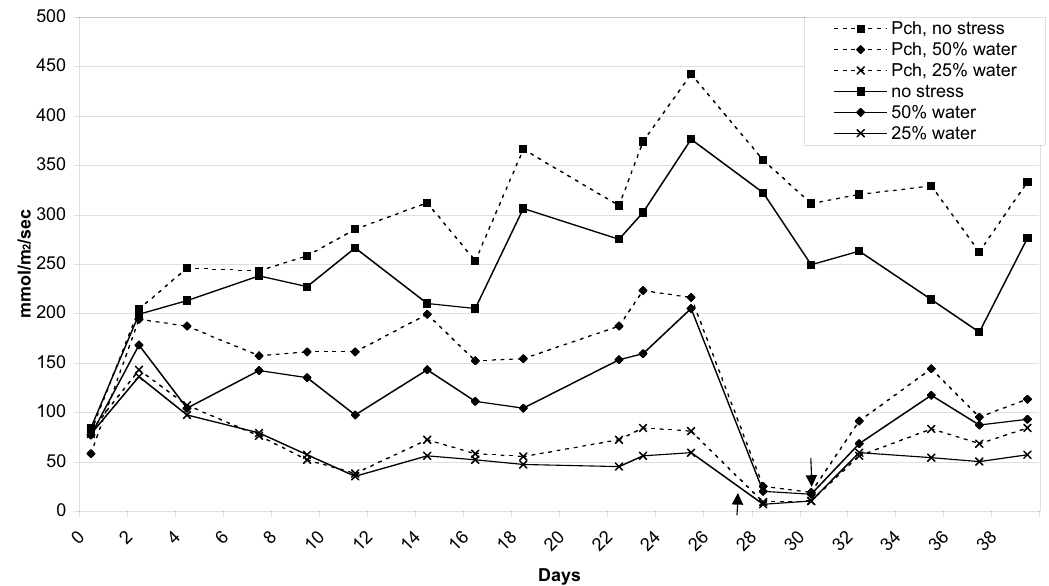
Fig. 5. Effect of water stress on stomatal conductance of infected and uninfected Chardonnay, March